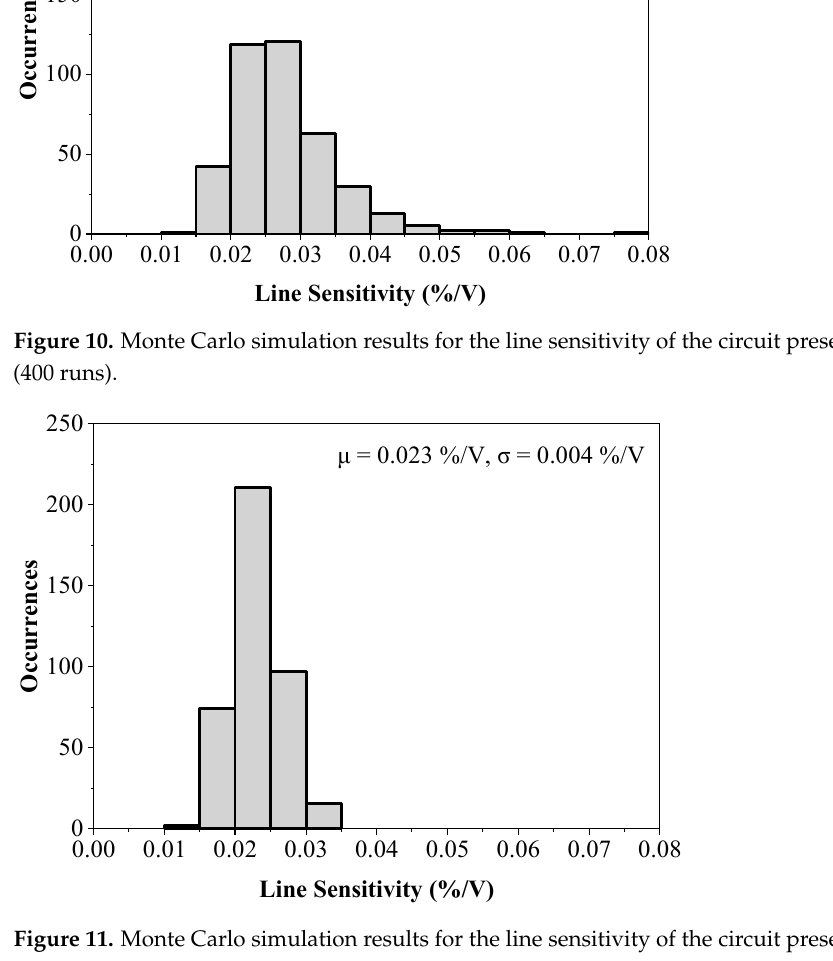
Figure 11. Monte Carlo simulation results for the line sensitivity of the circuit presented in Figure 6 using the optimal trimming code for each run (400 runs).